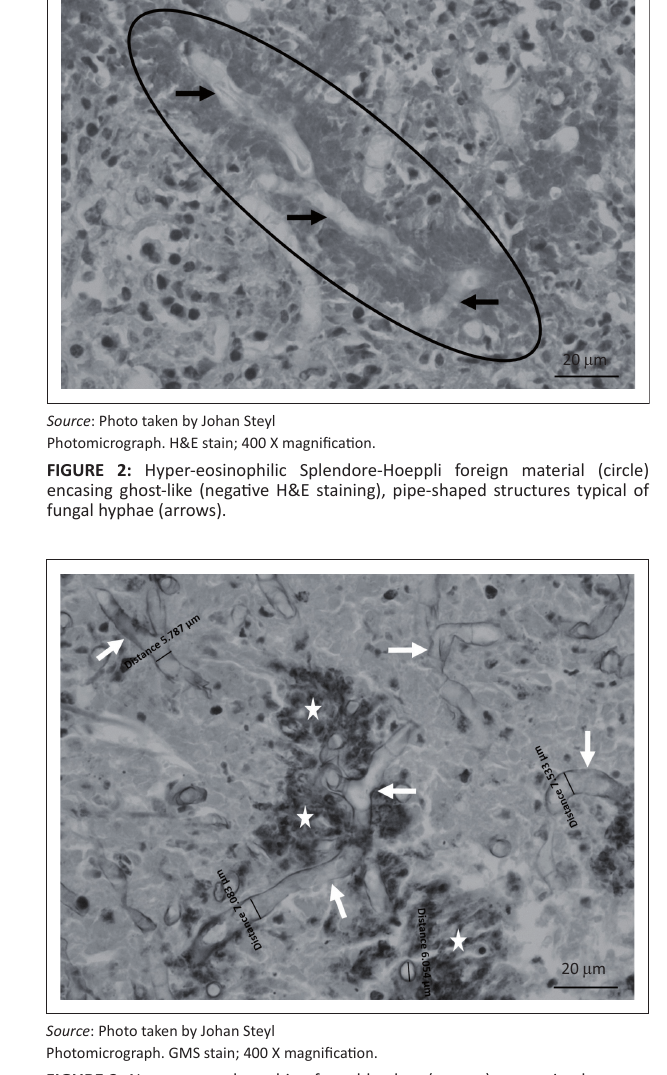
FIGURE 3: Non-septate, branching fungal hyphae (arrows) measuring between 5.7 µ m and 7.5 µ m in diameter among Splendore-Hoeppli foreign material (stars) and necrotic tissue